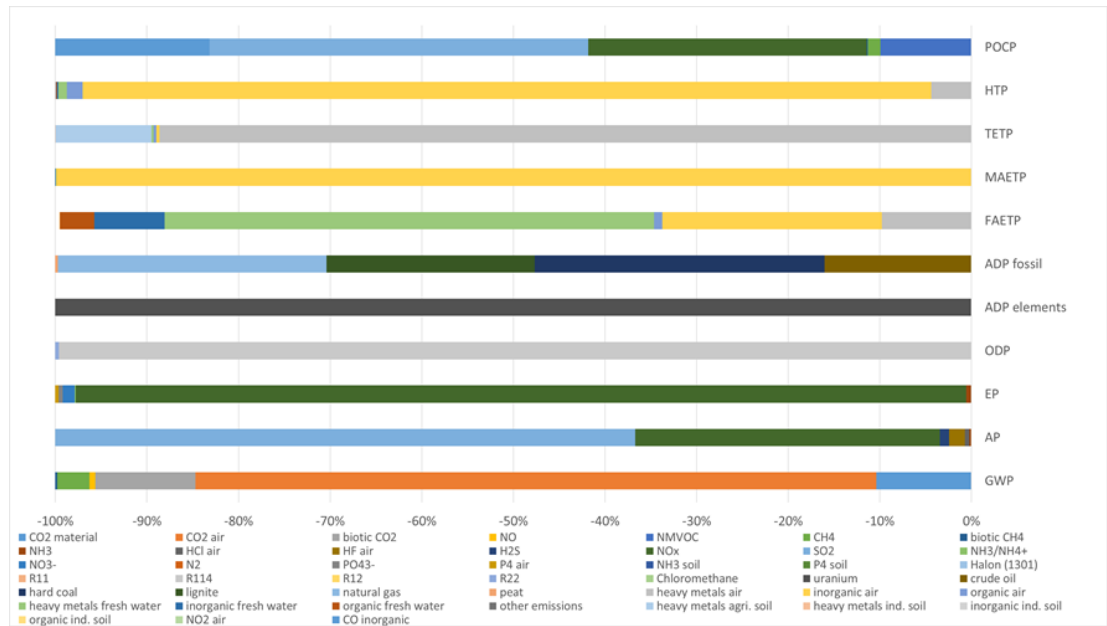
Figure 4. Impact categories and related emissions, for the two-stage plasma gasification of 1 ton of municipal solid waste (MSW).